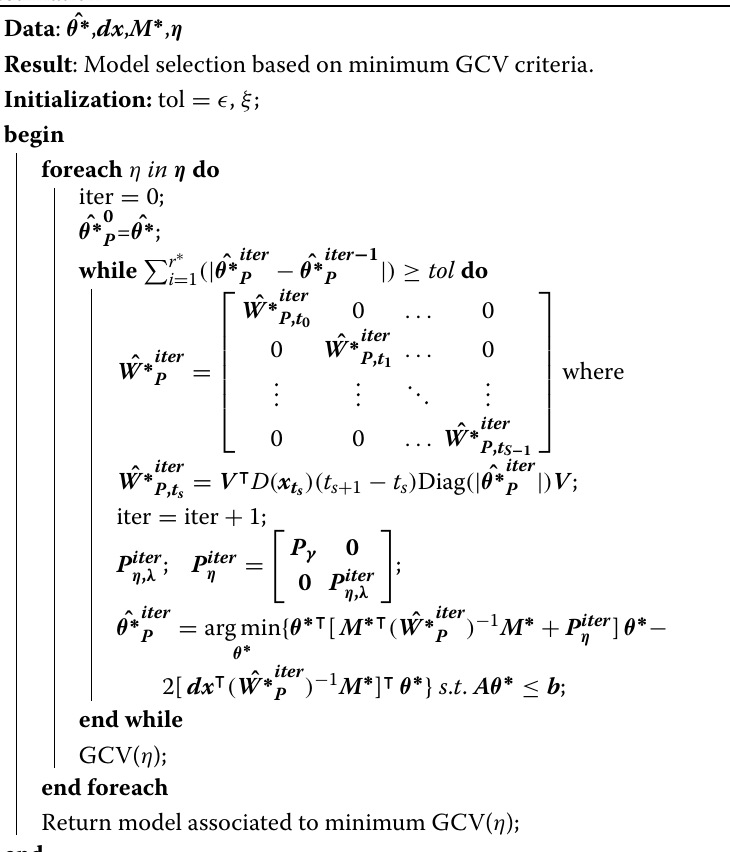
Algorithm 3: Iterative procedure for PCGLS based model selection and parameters